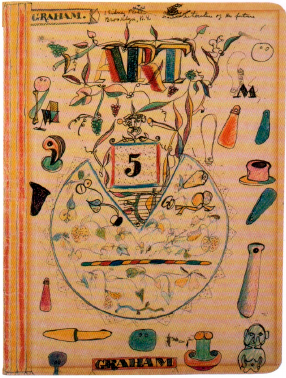
Figure 6. John Graham, Universe (Literature of the Future) recto, ca. 1940, mixed media, 11 1/2 × 8 in. (29.21 × 20.32 cm). Present location unknown.